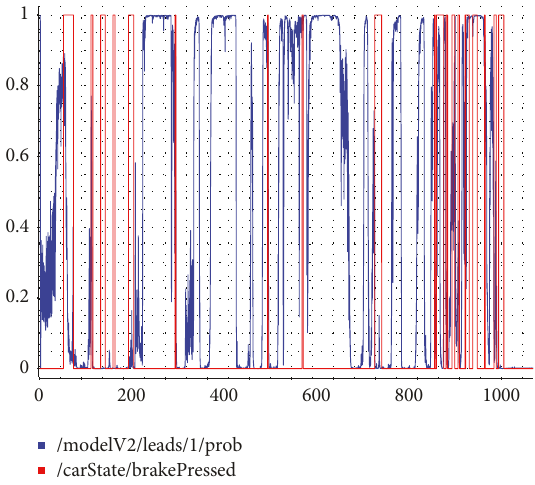
Figure 27: T1D6 lead car detection and braking.